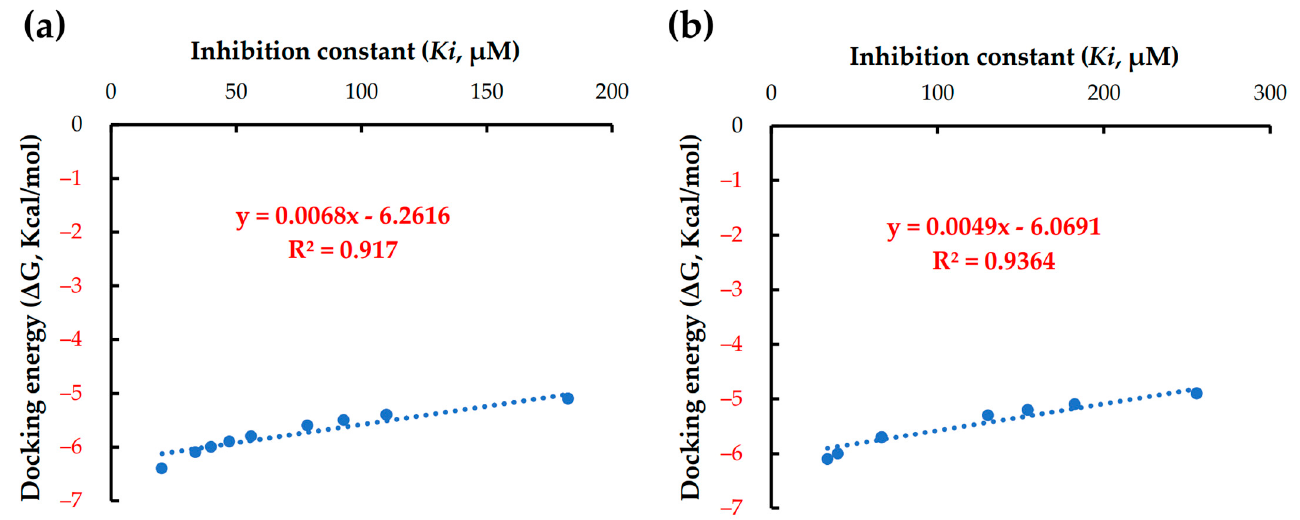
Figure 4. Regression analysis of docking energy ( Δ G) and inhibition constant ( Ki ) of ingredients-of- todomatsu oil on allergens Der f 1 ( a ) and Der p 1 ( b ).